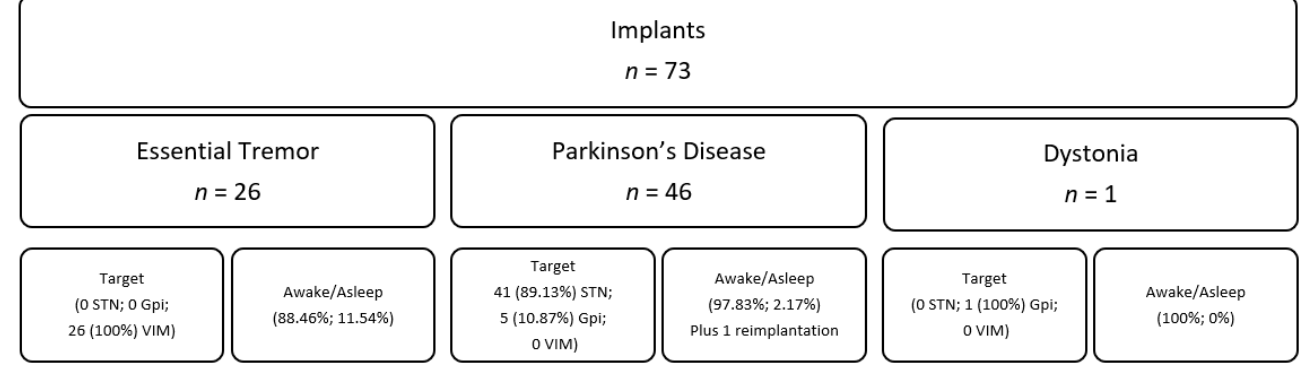
Figure 2. Conditions treated and brain targets in included patients.